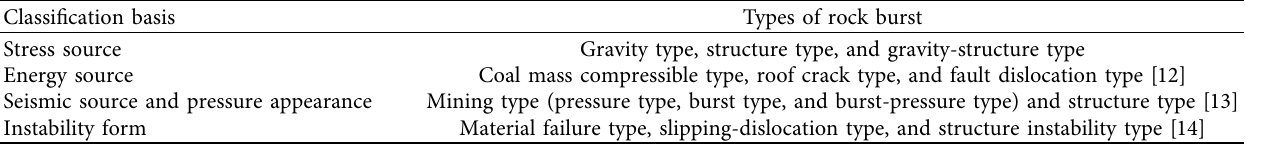
Table 1: Classification of rock burst in coal mine.